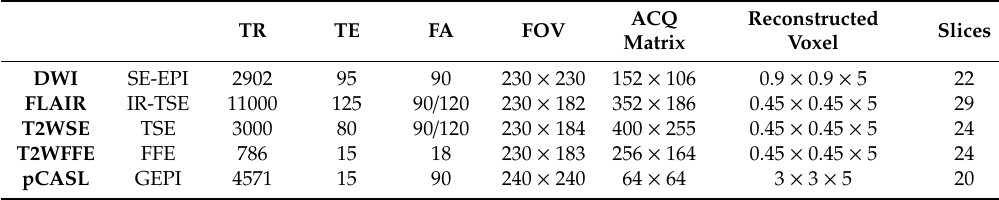
Table 1. Neuro-Oncology MRI protocol sequence